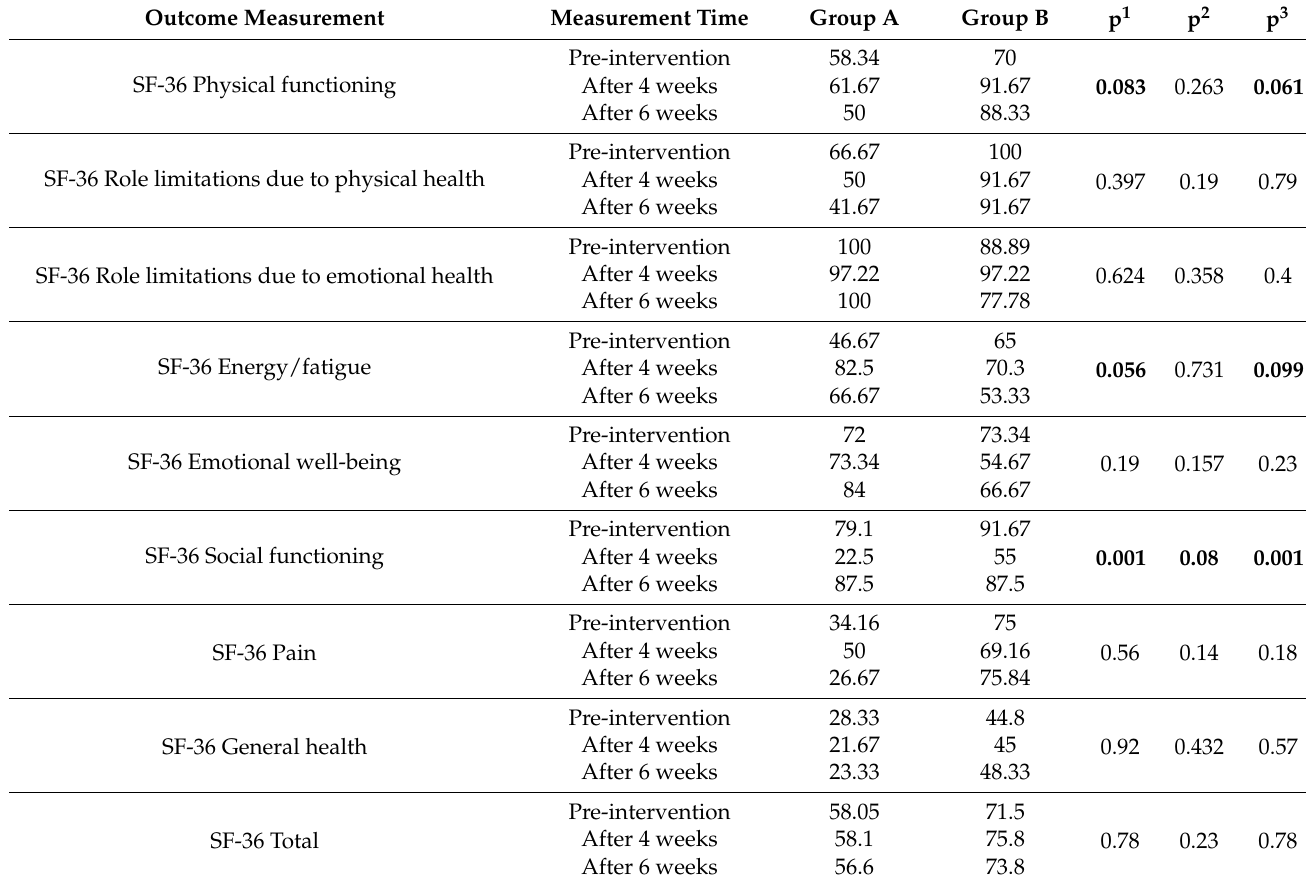
Table 4. Quality of life measured pre-intervention, after 4 weeks, and after 6 weeks using SF-36. Outcome